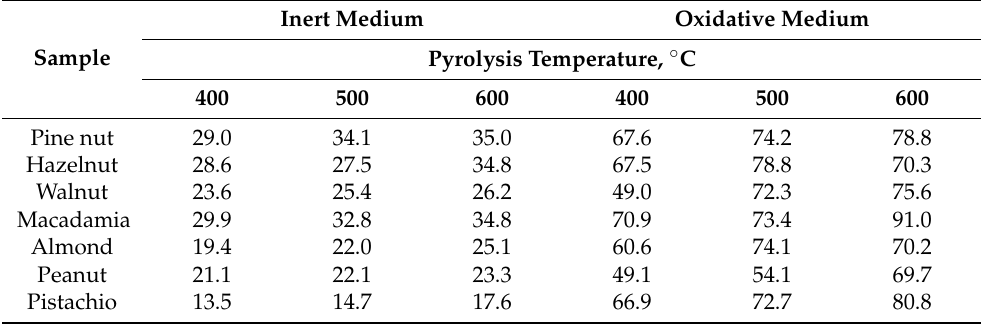
Table 4. Activation energy of biochar conversion in inert and oxidative medium E a ,